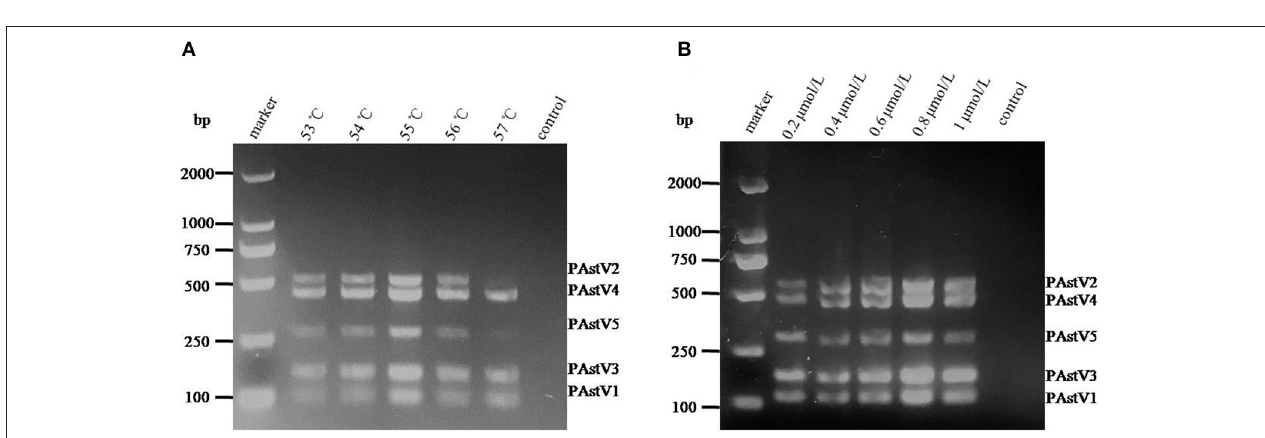
FIGURE 2 | Optimization of the multiplex RT-PCR conditions. (A) The standard plasmids of each porcine astrovirus (PAstV) genotype (10 ng each) were mixed and used as template for PCR amplification with combined primer sets at a final concentration of 1 µ mol/L. (B) The standard plasmids (10 ng each) were combined with the primer sets at different concentrations (0.2–1.0 µ mol/L) and amplified at an annealing temperature of 55 ◦